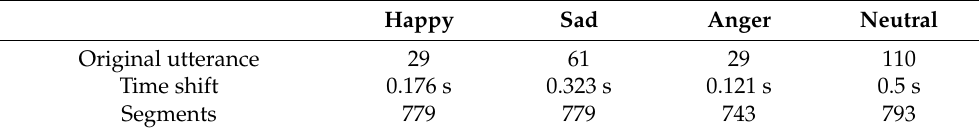
Figure 7. Spectrogram of one utterance sample. The x -axis represents the time series and y -axis represents the frequency. Table 3. Detailed data distribution of IEMOCAP Part1 after uniformly